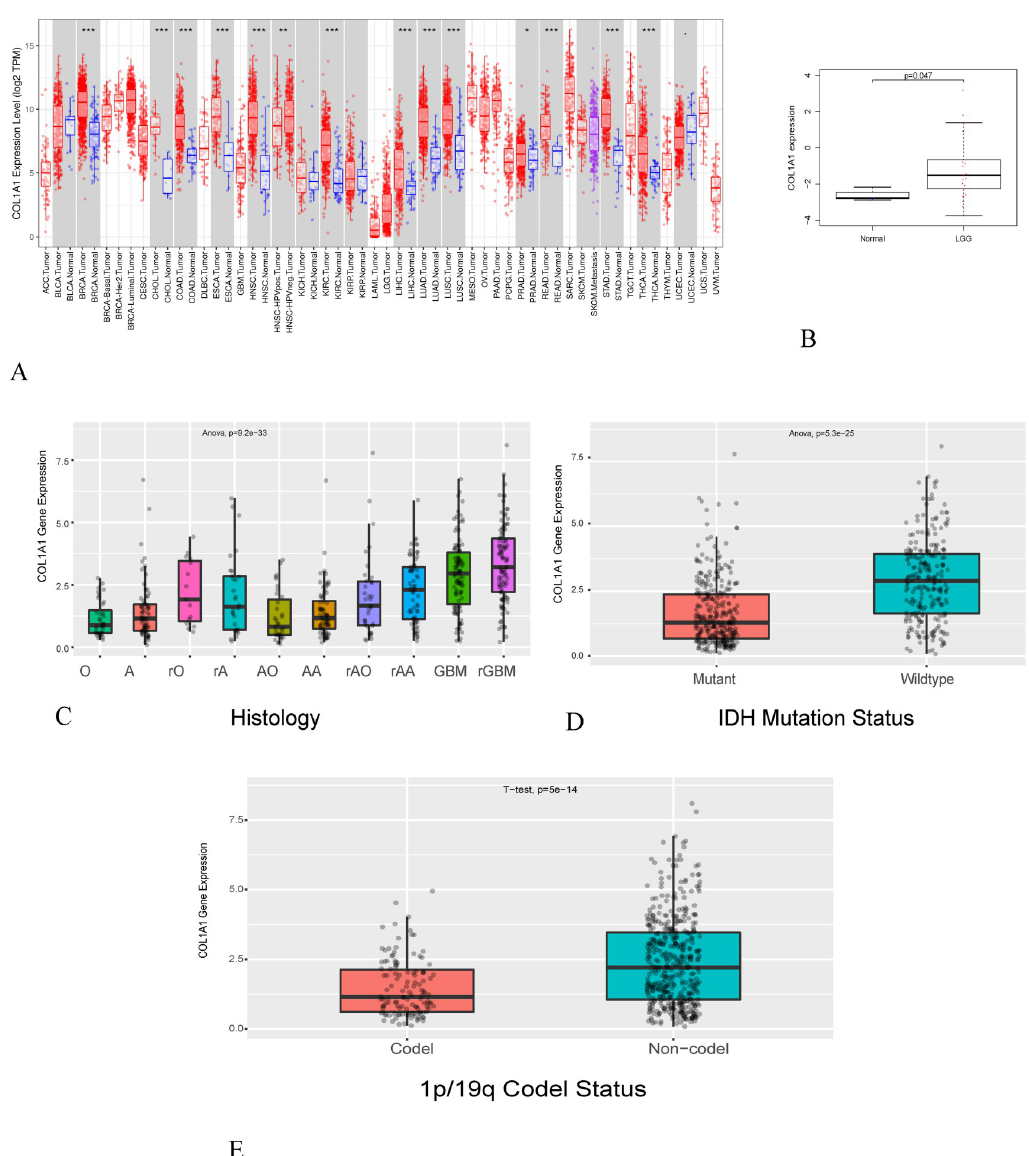
Fig 1. The expression level of COL1A1 in normal and tumor tissues. (A) In the TIMER database, the expression level of COL1A1 in different cancer tissues compared with normal tissues. (B) the expression level of COL1A1 in GEO. (C-E) The expression level of COL1A1 in different subtypes of glioma (A: Astrocytoma, O: Oligodendro, rO: recurrent Oligodendro, rA: recurrent Astrocytoma, AA: Anaplastic Astrocytoma, AO: Anaplastic Oligodendro, rAA: recurrent Anaplastic Astrocytoma, rAO: recurrent Anaplastic Oligodendro, GBM:Glioblastoma, rGBM: recurrent Glioblastoma. �� P < 0.05, �� P < 0.005, ��� P < 0.001).